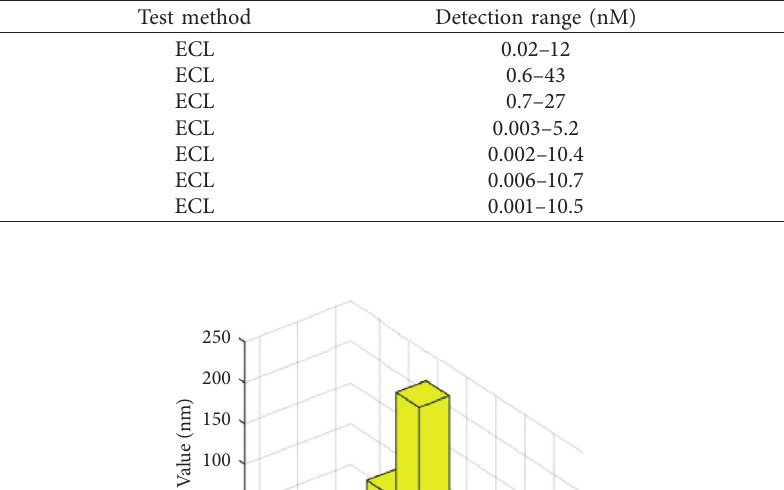
Table 2: Performance comparison between ECL aptamer and other